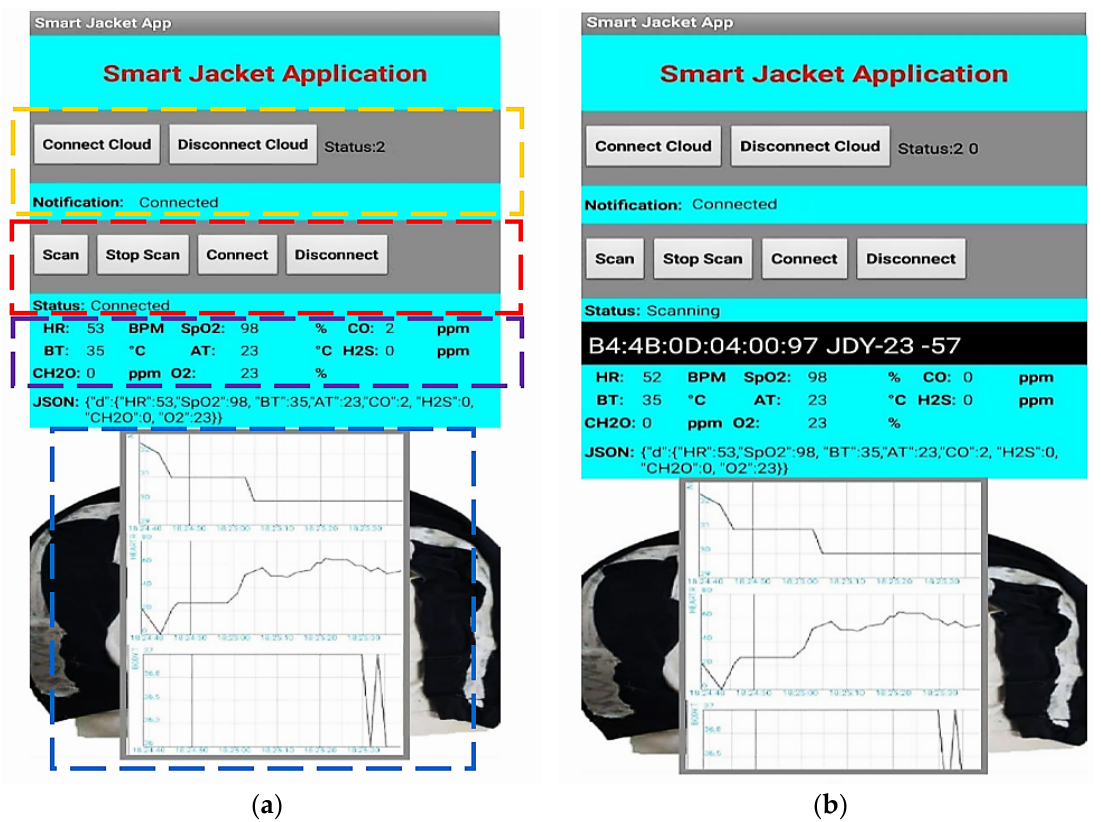
Figure 19. Screenshots of the developed Android application: screen with the data transmitted by the developed smart garment and sent to the cloud platform with the different sections highlighted ( a ) and screen during the BLE connection phase ( b